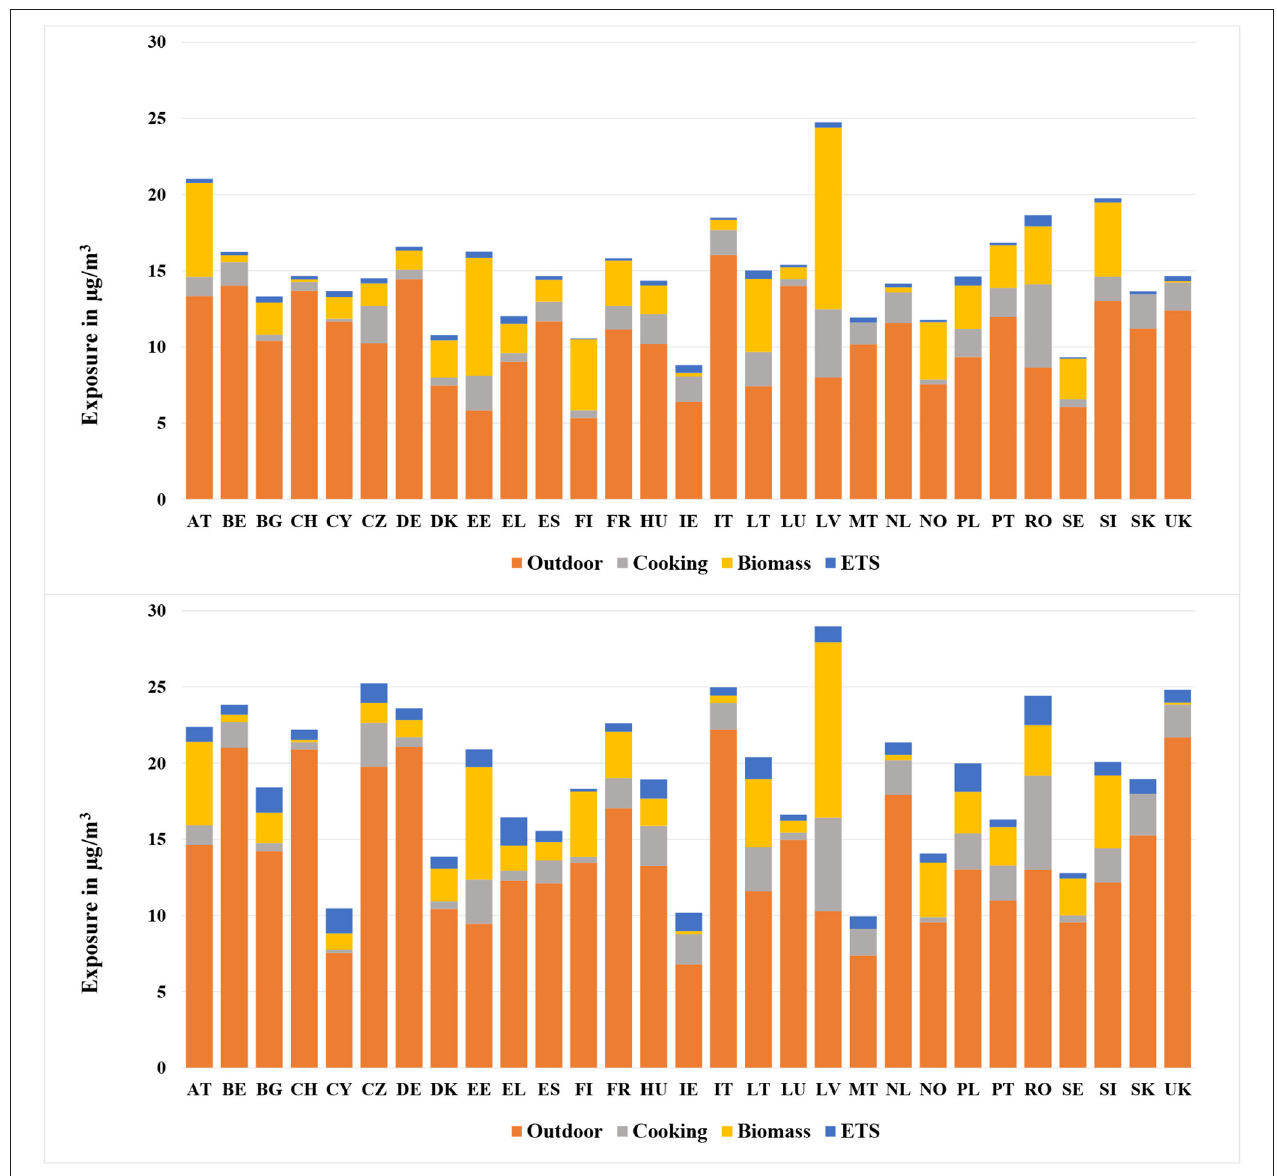
FIGURE 6 | Population-weighted arithmetic mean NO 2 exposure for different European countries in 2015 (upper) and 1990 (lower).